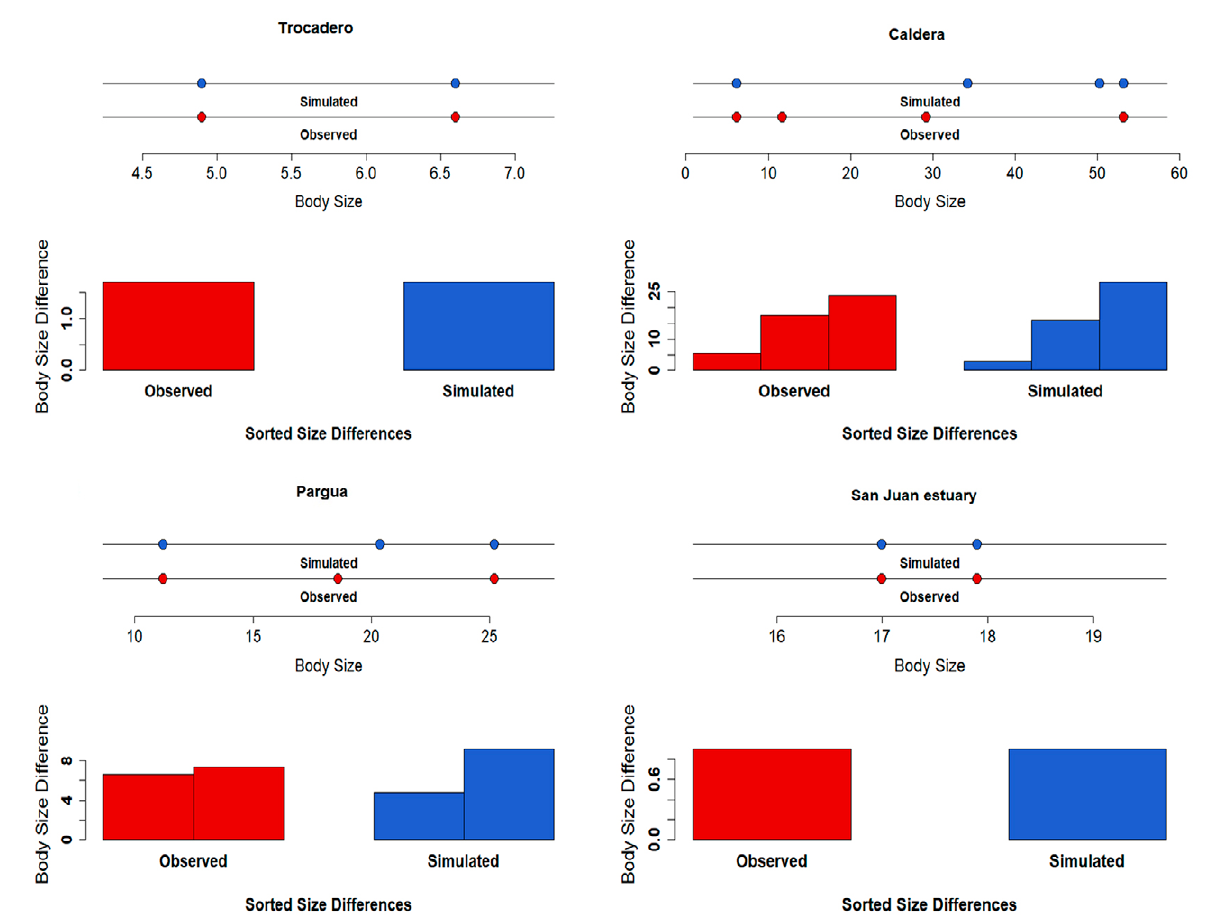
Fig. 2. – Graphs of results of the size overlap null model for the study